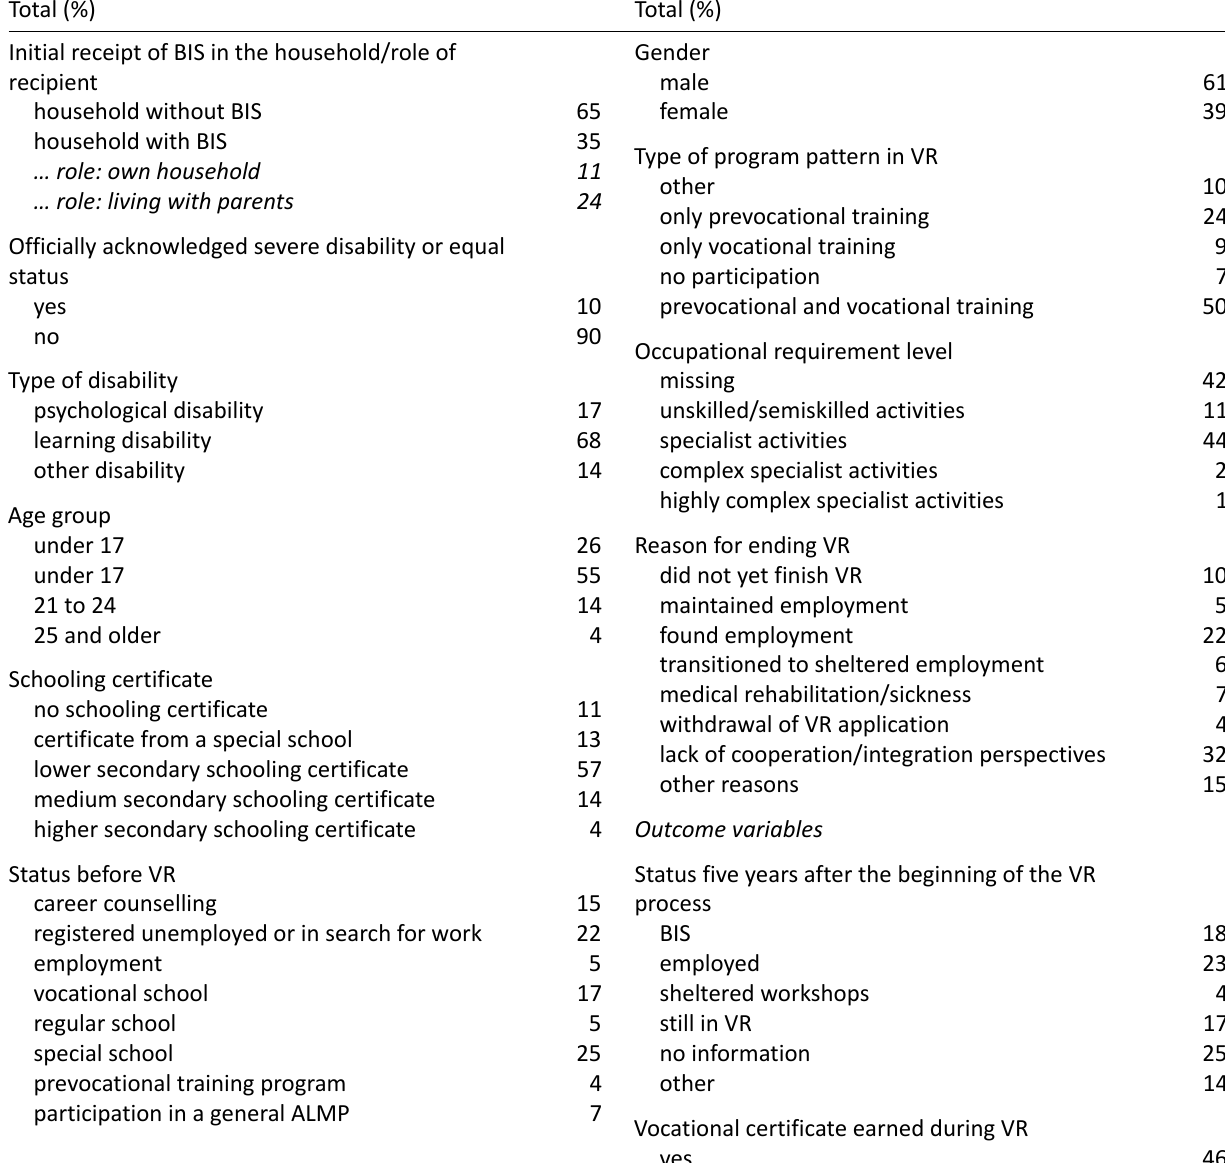
Table 1. Descriptive statistics of the